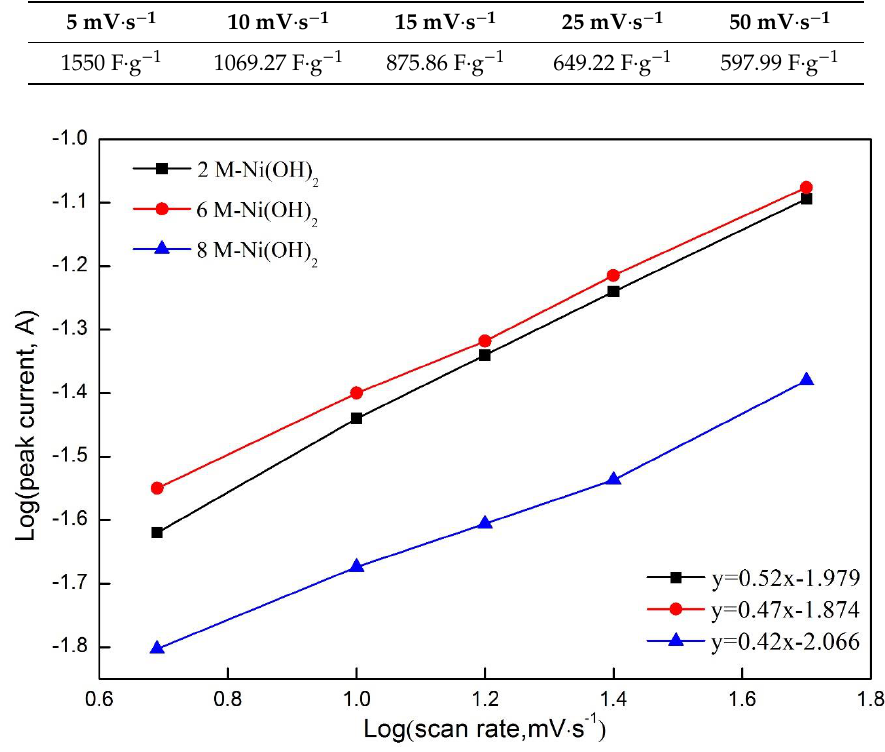
Table 3. Specific capacitance values of the 6 M-Ni(OH) 2 samples at di ff erent scanning rates.